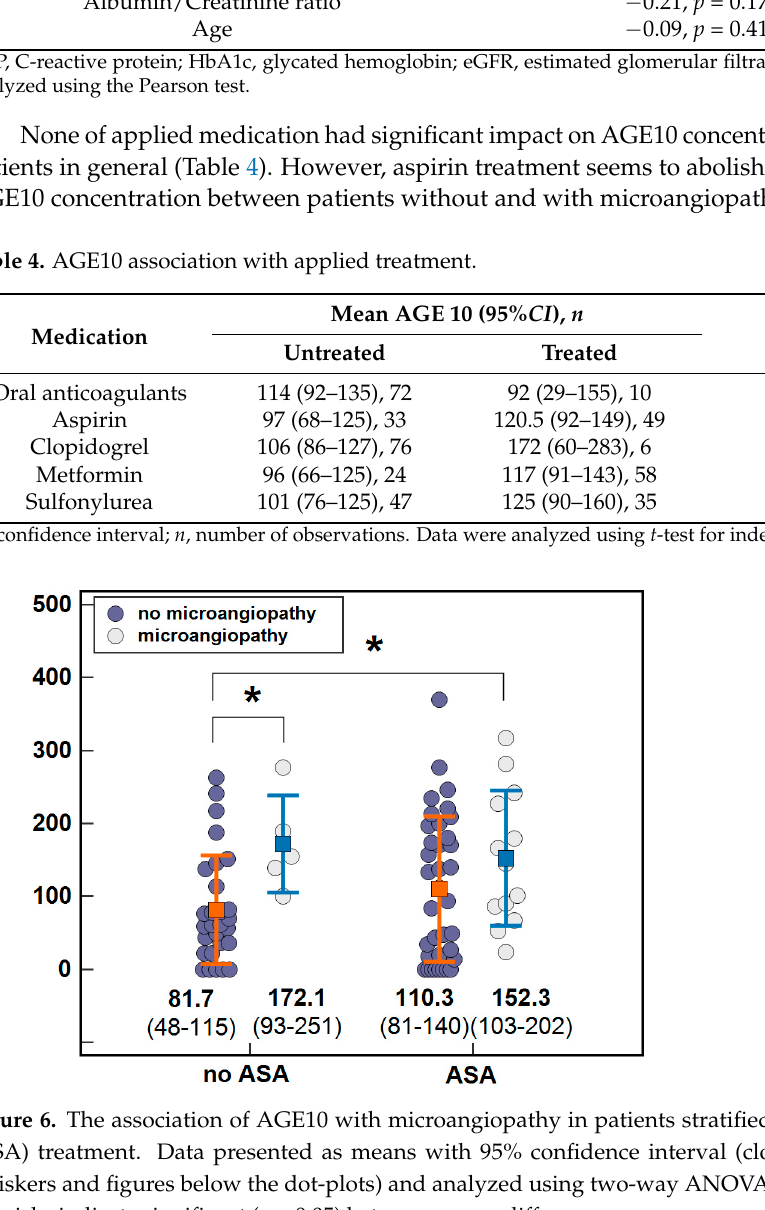
Table 4. AGE10 association with applied treatment